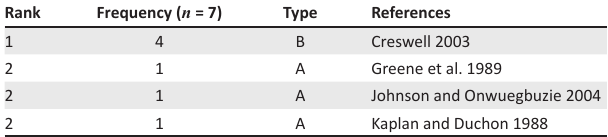
TABLE 2: The most-cited mixed methods research